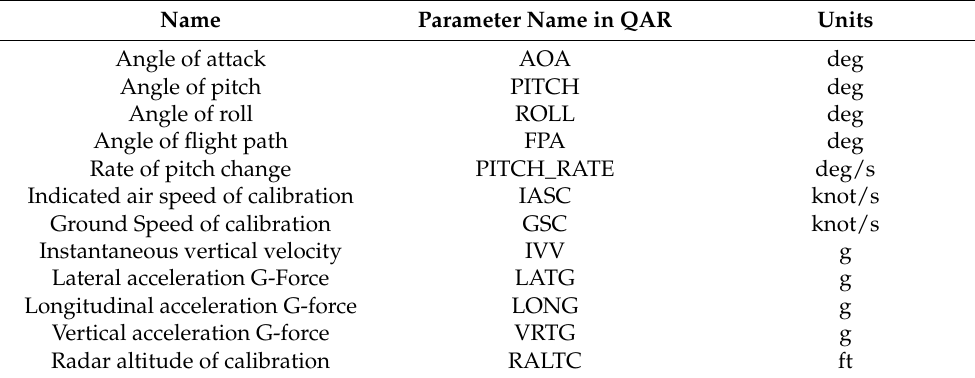
Table 1. The details of the selected flight parameters.